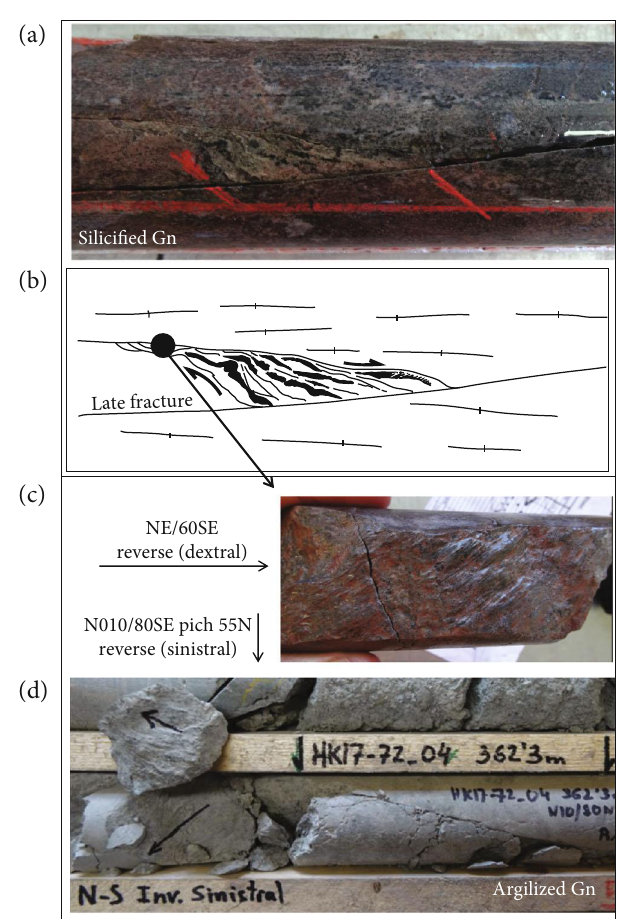
Figure 7: Kinematic indicators on drill core samples from Sue (a, b, and c) and Spit fi re (d), illustrating (a) crack-seal mineralization in drill hole S835@366m. (b) Interpretation of (a): pitchblende is hosted in oblique/sigmoidal quartz veins lenses (crack-seal) that run parallel or subparallel to the foliation. (c) Slickensides. Reverse dextral kinematics is deduced from (a) and (c). (d) Slickensides on drill core sample from Hook Lake (HK17-72@362.3m) indicating reverse sinistral